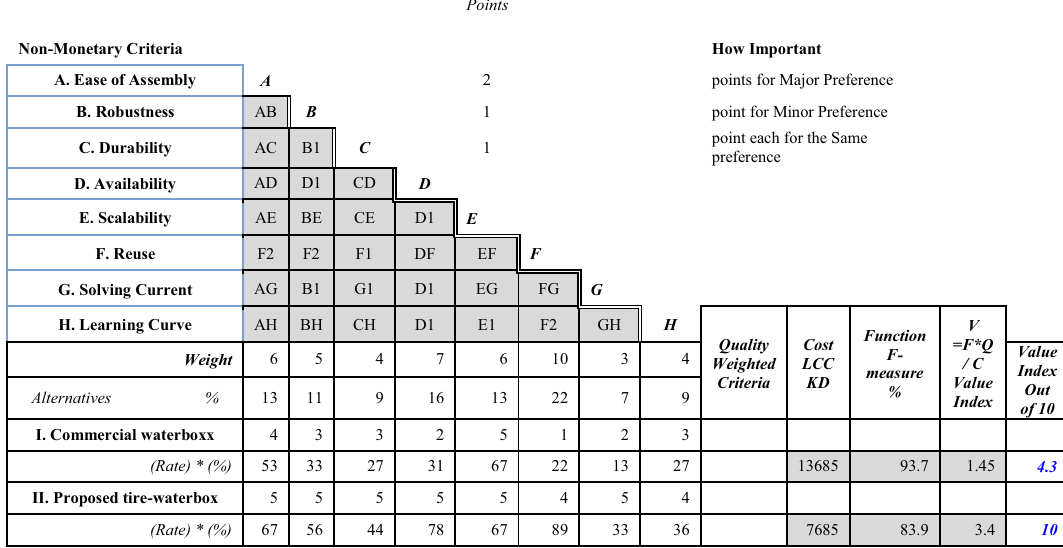
Table 11. Value index calculation of original and new designs.